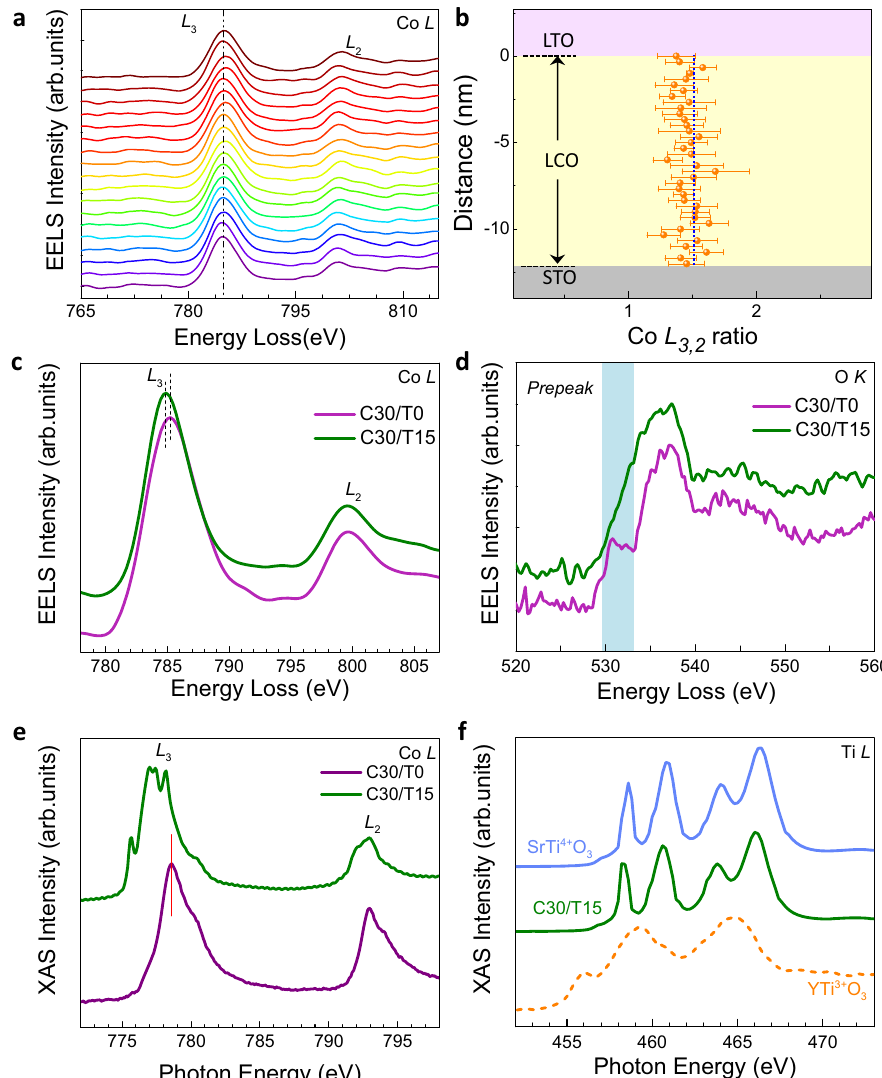
Fig. 2 EELS and XAS of C30/T n heterostructures. a The Co L -edge EELS spectra of C30/T15 at different positions from STO/LCO to the LCO/LTO interface. The bottom curve is from the STO substrate/LCO interface, and the uppermost curve is from the LCO/LTO interface. b The corresponding Co L L -edge and d O K -edge EELS spectra of C30/T15 and C30/T0. The shadow 3,2 intensity ratio. The LCO/LTO interface sets for zero. The averaged c Co area in d indicates the distinct difference in the pre-peak feature. The spectra were averaged from the line scan in the 30u.c. LCO block. e Co L -edge XAS spectra of the C30/T15 and C30/T0 samples. f The Ti L -edge XAS spectra of the STO substrate, C30/T15, and 100-nm YTiO 3 fi lm from ref. 10